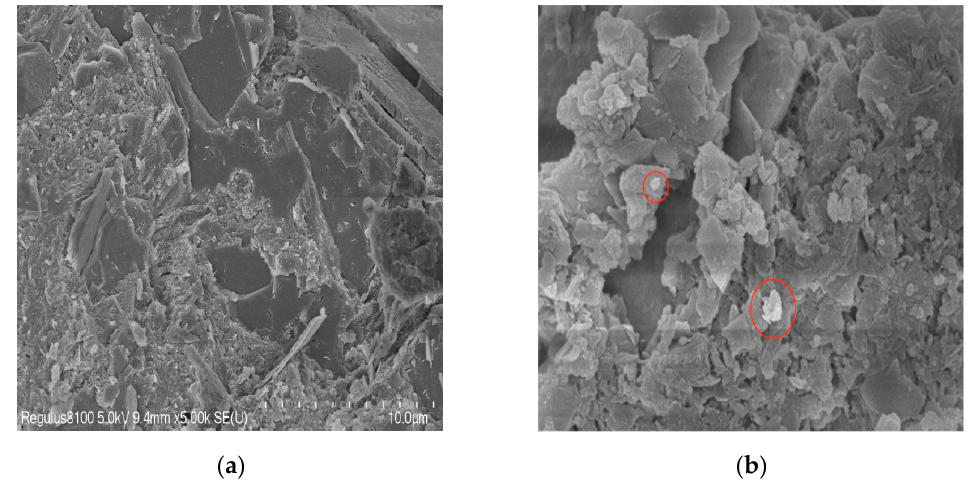
Figure 9. SEM image of 3 d concrete specimen. ( a ) SEM diagram of concrete specimen without water-added temperature rise inhibitor 3 d; ( b ) SEM diagram of concrete specimen doped with 1.0%SBT hydration temperature rise inhibitor.